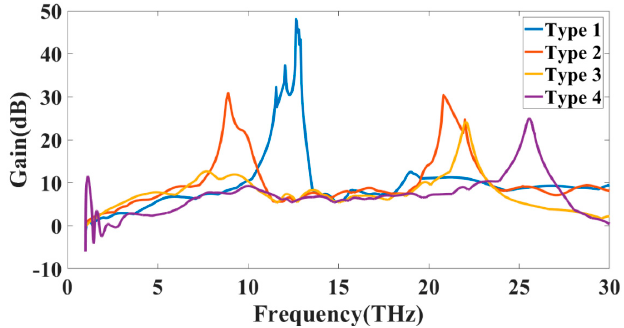
Figure 6. Calculated gain for the different types of antenna.